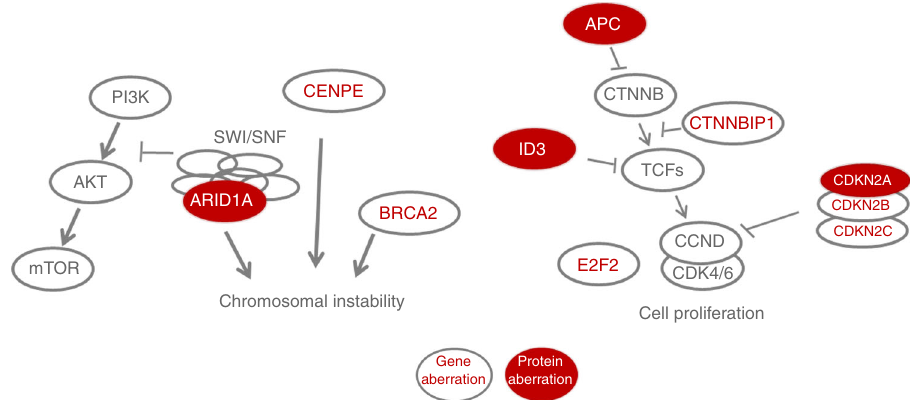
Fig. 6 Analyses reveal aberrations in genome stability and cell cycle control in